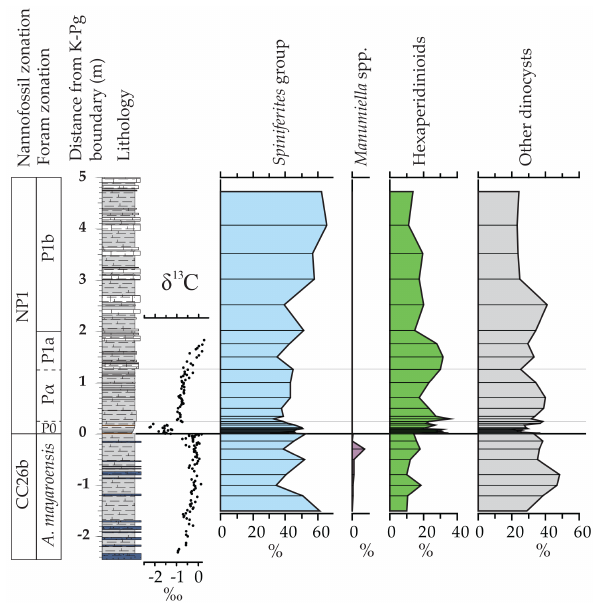
Figure 3. The organic-walled dinoflagellate cyst record of the Okçular section. The biostratigraphy and bulk carbonate stable car- bon isotope records are from Açikalin et al. (2015). The four main dinocyst complexes are